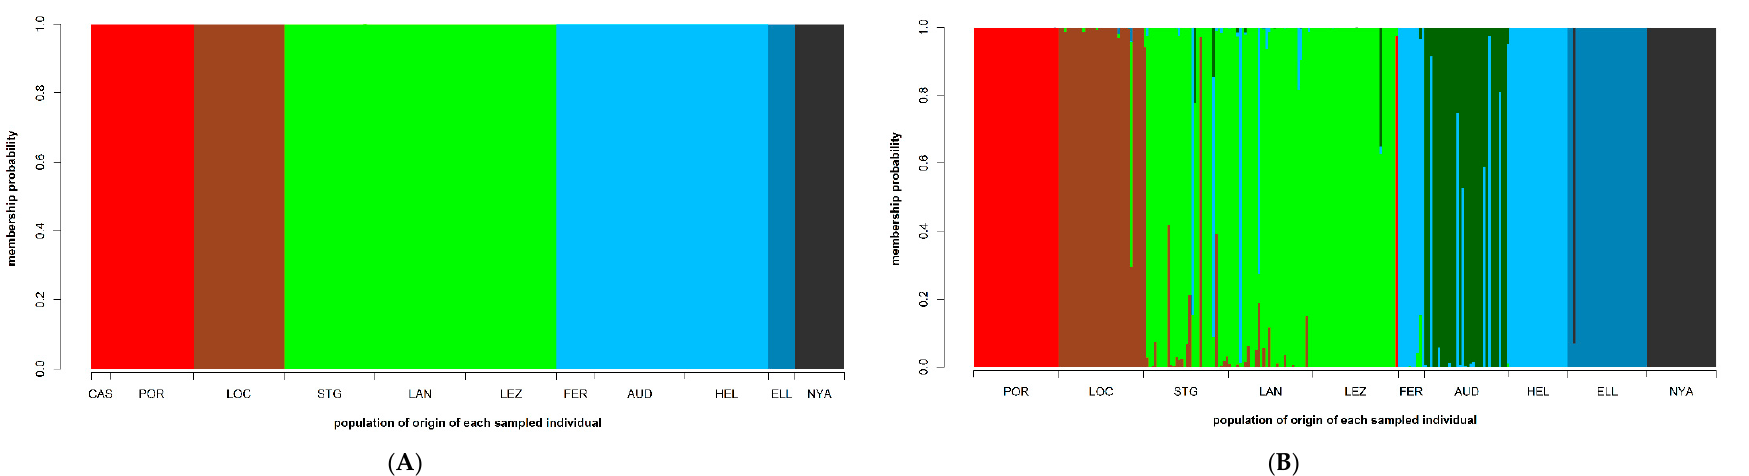
Figure 3. (A) Membership probability of the 199 S. latissima sporophytes (each sample is represented by a vertical bar) to each of six genetic clusters (each represented by a unique color) that were determined by the snapclust algorithm that was run on this set of samples utilizing 4069 SNP markers (see Supplementary Materials Figure S3A,B). The sampling locality of each individual is specified along the x-axis. (B) Membership probability of the 280 S. latissima sporophytes (each sample is represented by a vertical bar) to each of seven genetic clusters (each represented by a unique color) that were determined by the snapclust algorithm that was run on this set of samples utilizing 18 SSR markers (see Supplementary Materials Figure S3C,D). The sampling locality of each individual is specified along the